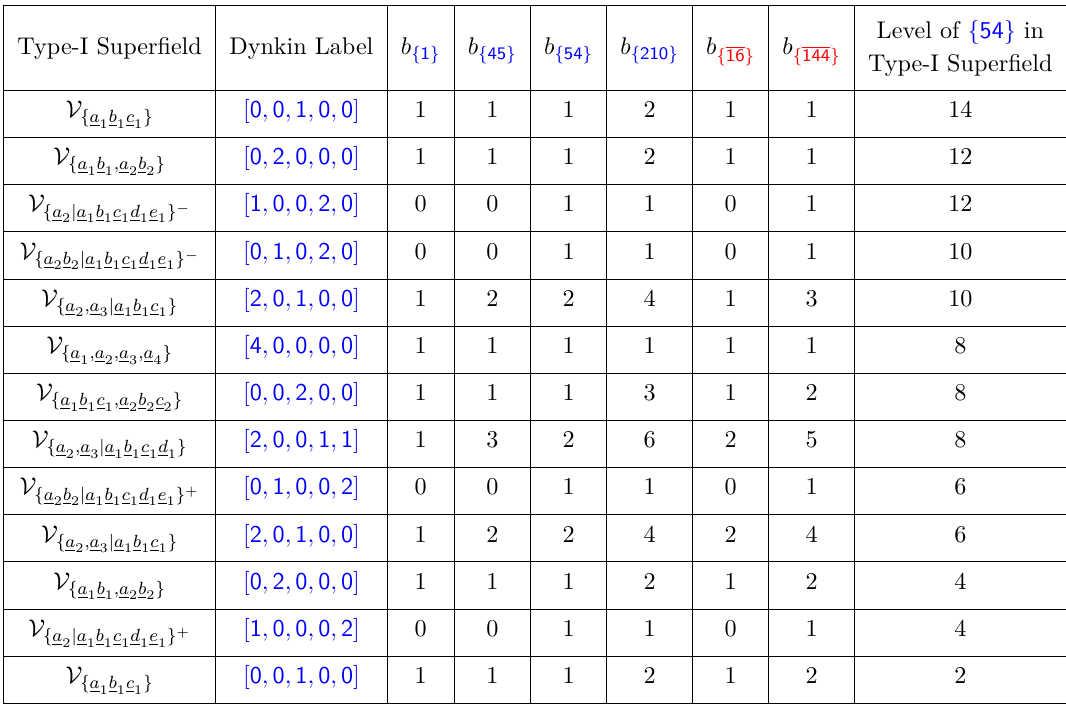
Table 2 . Contributions of Each Type-I Superfield to the component bosonic and fermionic rep- resentation content of the 10D, N = 1 supergravity multiplet at Level-16/17 of Type-IIA Scalar Superfield